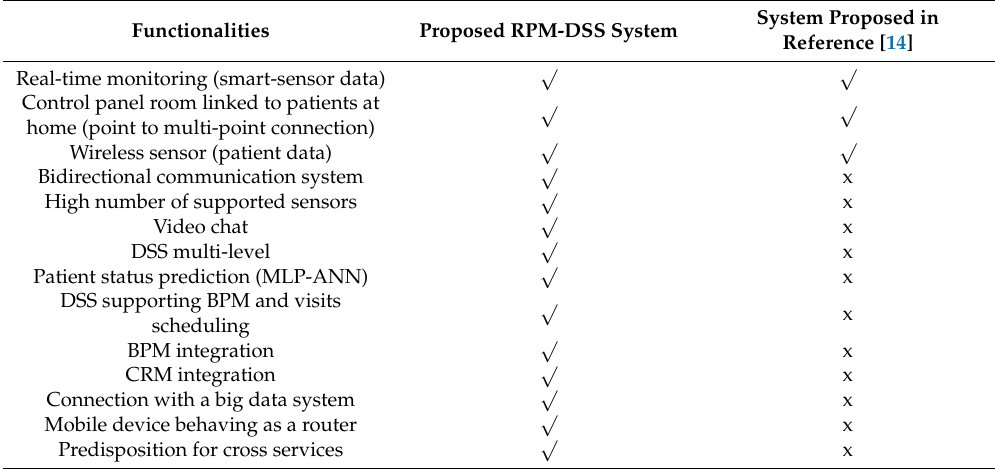
Table 1. Features and advantages of the RPM-DSS and system proposed in Reference [14].